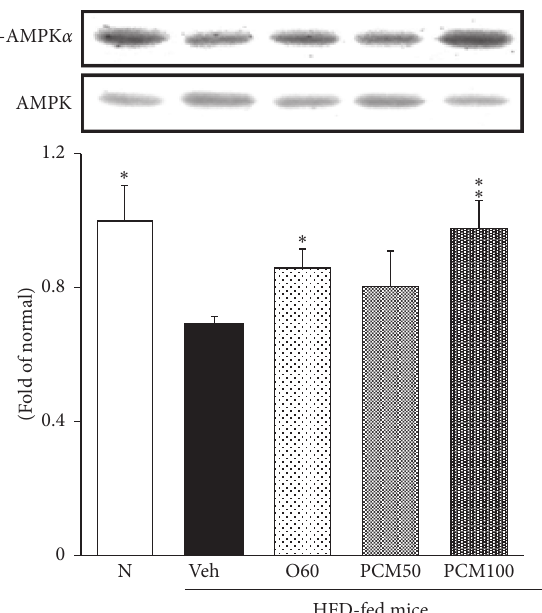
Figure 3: p-AMPK protein expressions in the liver. N, normal mice; Veh, HFD control mice; O60, orlistat 60mg/kg-treated and obese mice; PCM50, PCM 50mg/kg-treated and obese mice; PCM100, PCM 100 mg/kg-treated and obese mice. Data are the mean ± SEM, n � 7. Significance: ∗ p < 0.05 and ∗∗ p < 0.01 versus HFD control mice. p-AMPK, phosphor-AMP-activated protein